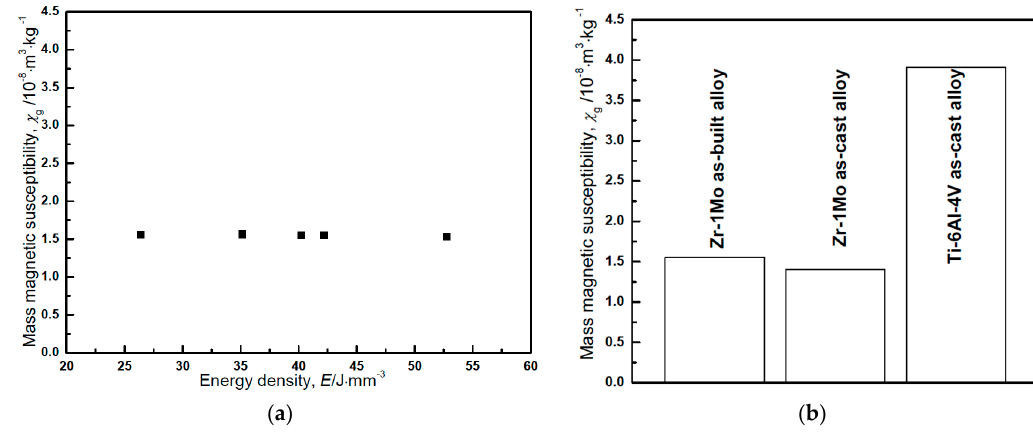
Figure 10. ( a ) The mass magnetic susceptibility of the as-built Zr-1Mo alloys with various energy densities; ( b ) The magnetic susceptibility of the as-built Zr-1Mo alloys averaged from specimens subjected to PBF (powder bed fusion), as-cast Zr-1Mo alloys, and Ti-6Al-4V ELI (Extra Low Interstitials) alloy.